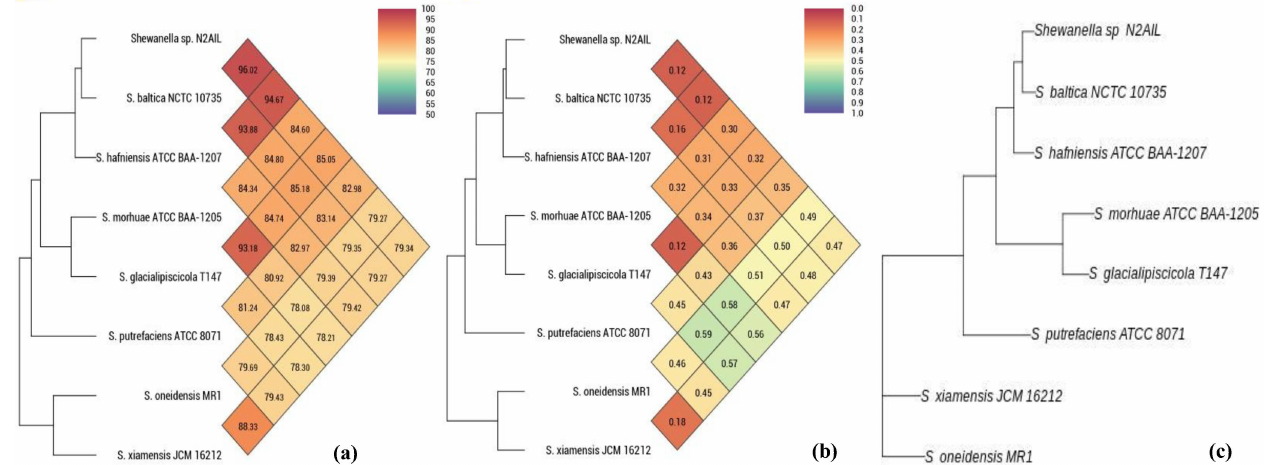
Figure 3. Heat map and phylogenetic tree based on ANI ( a ), GGDC distance ( b ), and whole-genome sequence of Shewanella sp. N2AIL ( c ) with its closely related